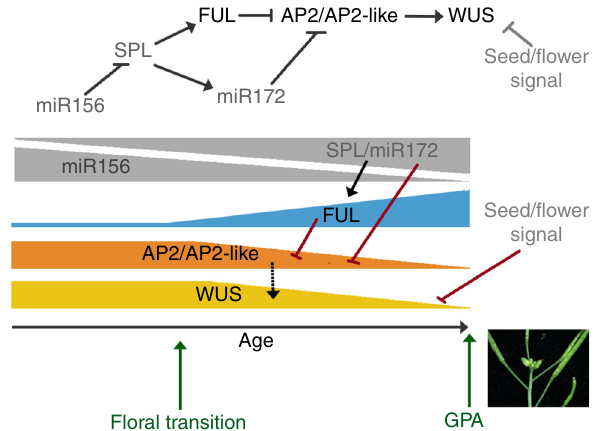
Fig. 5 Model for temporal regulation of in fl orescence meristem maintenance. WUS levels in the in fl orescence SAM decrease with plant age. WUS expression is under positive regulation of AP2 and AP2-like factors in the SAM and negative regulation of an unknown signal from developing fl owers/fruits. It has been previously shown that during the plant ’ s life cycle, levels of miR156 decrease with age,